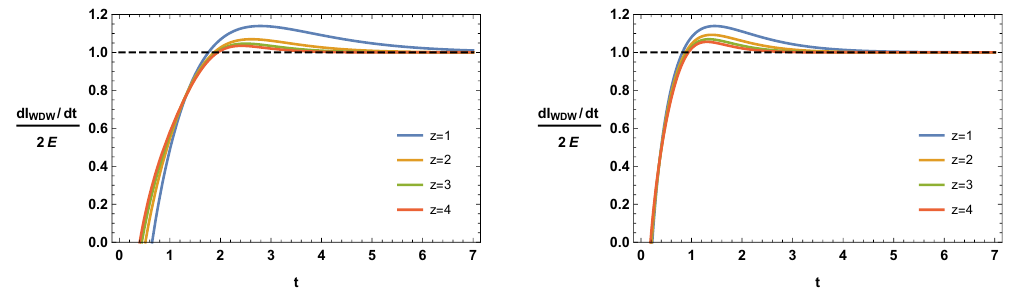
Figure 2 . Rate of the complexity growth in a WDW patch for two sided black brane. Left (right) panel shows di(cid:11)erent values of dynamical exponent for d e = 1( d e = 2). For each curve on both panels the Lloyd’s bound is violated at some time before the curve reaches unity on the vertical